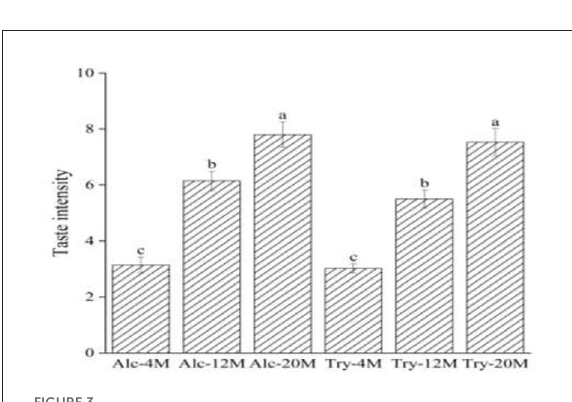
FIGURE3 Bitterness intensity scores of different extracts. The values in a column followed by different letters were significantly different ( p <